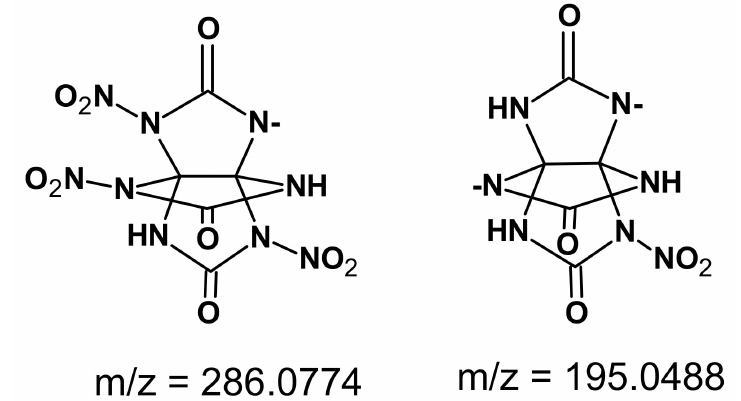
Figure 4. Fragments of 23